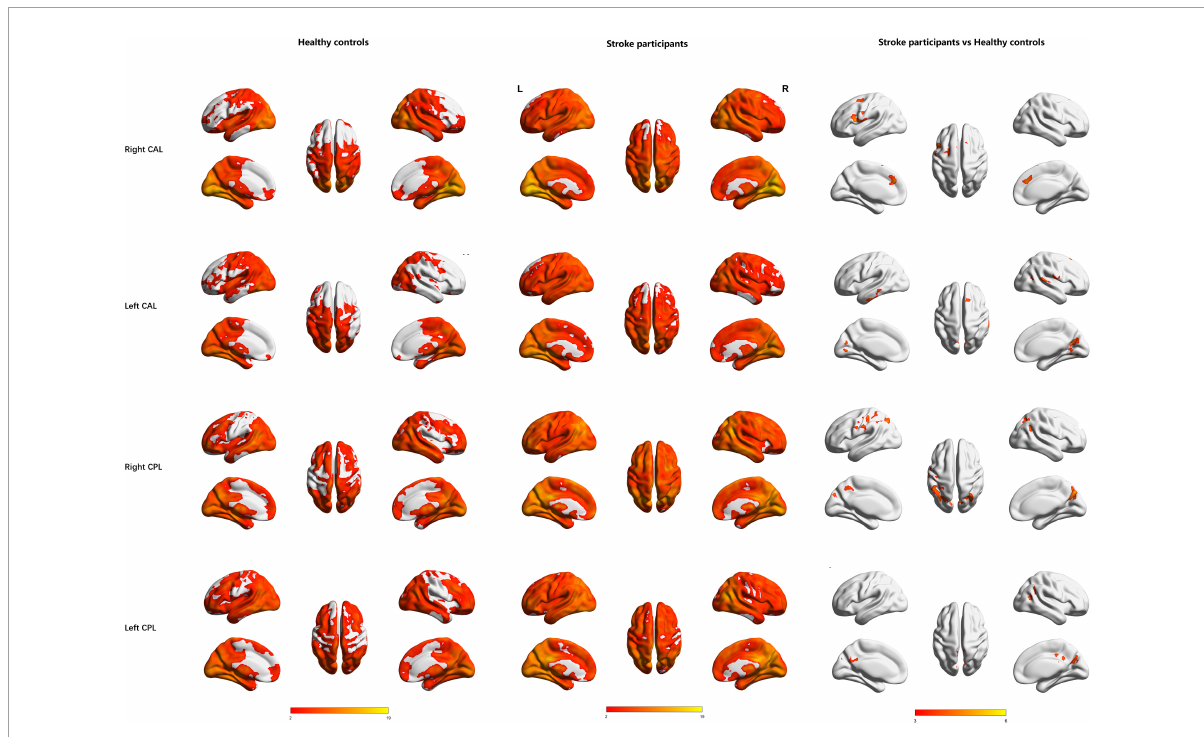
FIGURE3 Regions showing significant functional connectivity with the bilateral cerebellar anterior lobe and cerebellar posterior lobe in the healthy controls (1st row) and stroke participants (2nd row) and regions showing significant differences between groups (3rd row). L, Left; R, Right; CAL, cerebellar anterior lobe; CPL, cerebellar posterior